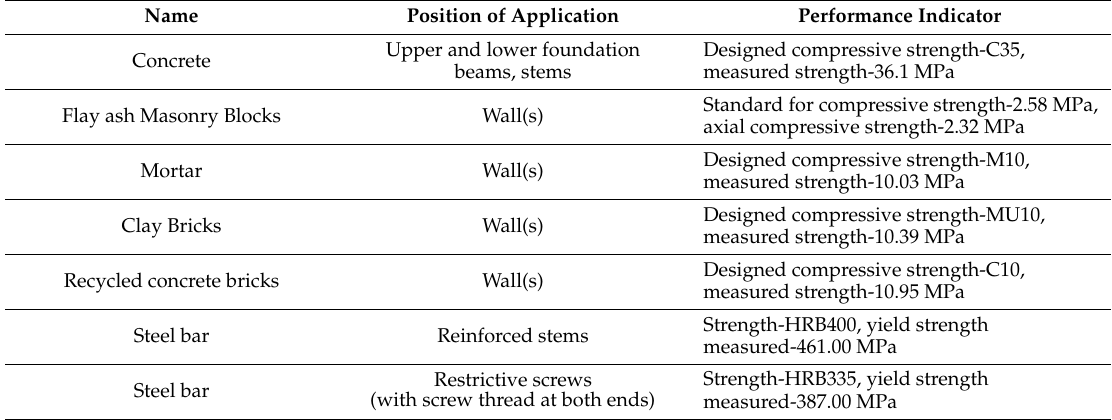
Table 3. Performance Index of Materials Applied.